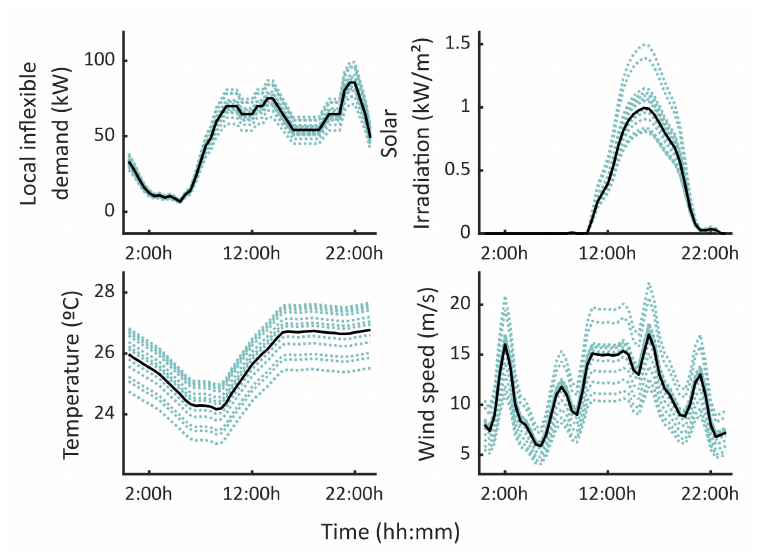
Figure 7. Forecasted profiles (solid lines) and scenarios (discontinuous lines) used for modelling uncertain parameters in simulations.